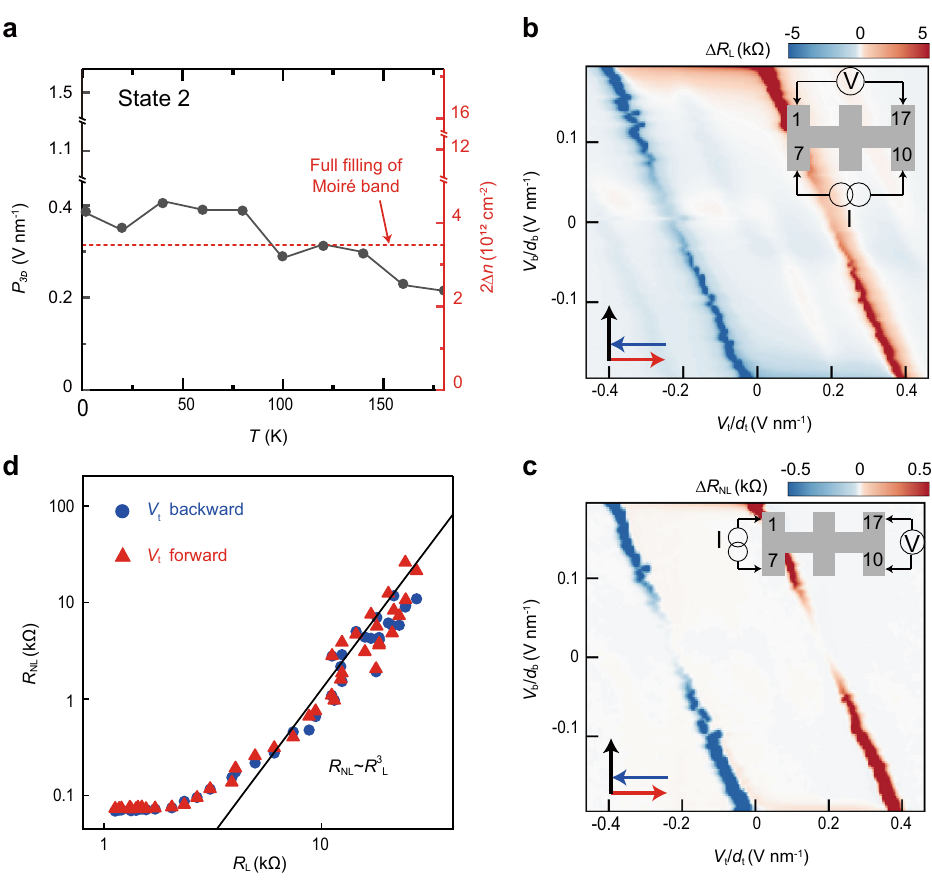
Fig. 5 | Ferroelectric switching of topological valley current. a The internal electrical polarization P 3D (State 2) keeps almost the same below 100K, but gra- dually decays at higher temperature. b , c Local b and nonlocal c signals are